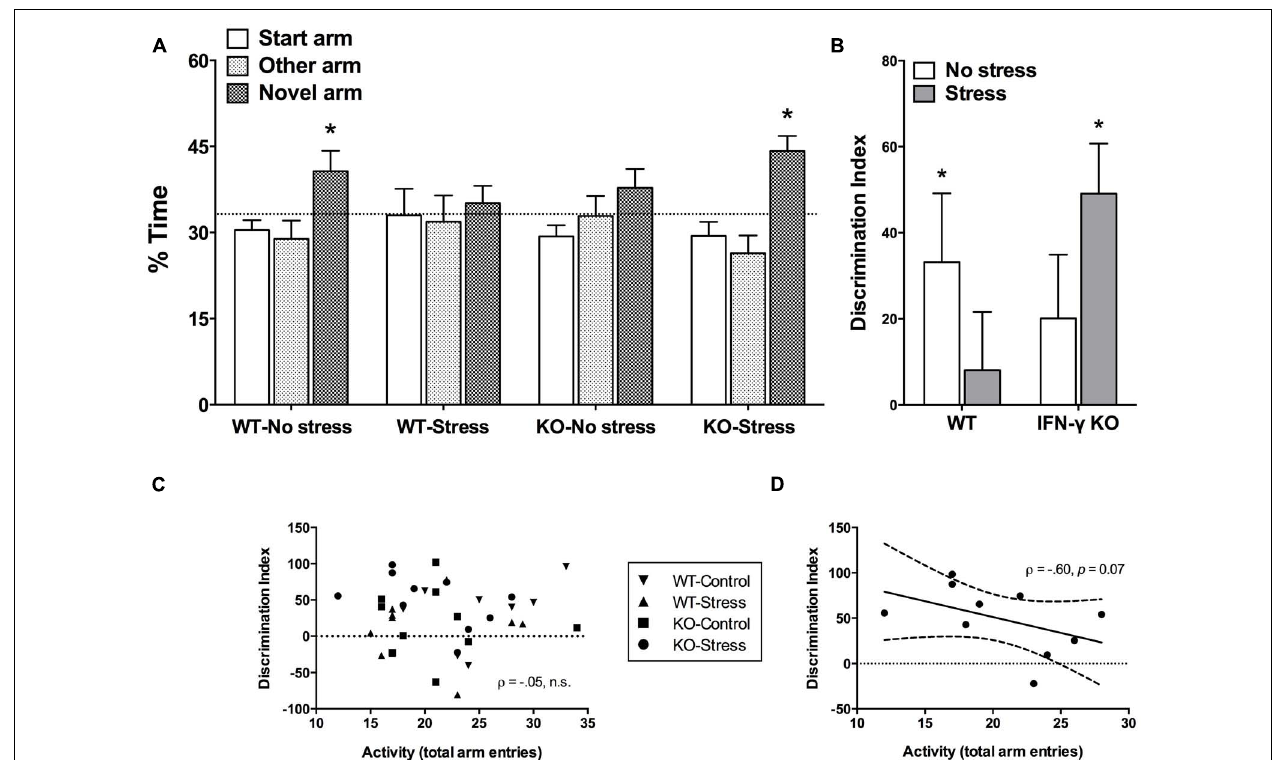
FIGURE 3 | Impact of IFN- γ deletion on short-term spatial memory function under basal vs. chronic stressor conditions. As regards both the percentage (%) time spent exploring the novel arm of the Y-maze (A) and the novelty discrimination index (DI; B) , of the four treatment groups, only the non-stressed wild-type controls and the chronically stressed IFN- γ knockout mice performed at a level significantly above chance (33.3% and 0, respectively). While overall there was no association between DI scores and total Y-maze arm entries (C) , when